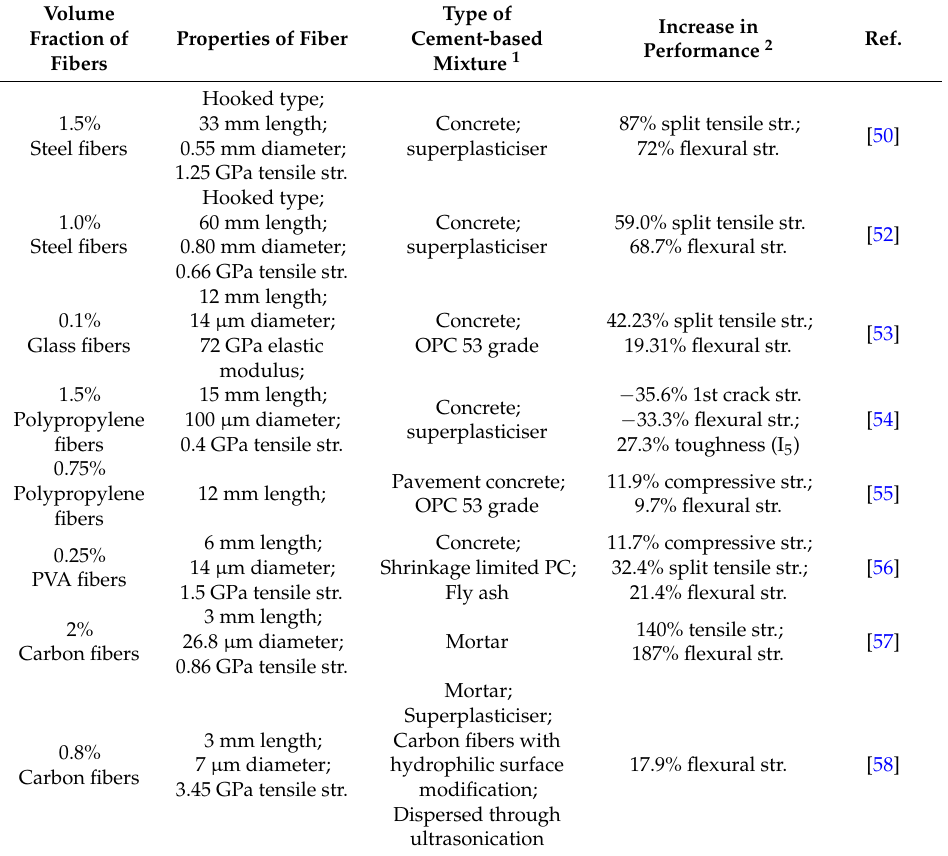
Table 2. Examples of improvement in strength (str.) by fibers in cement-based